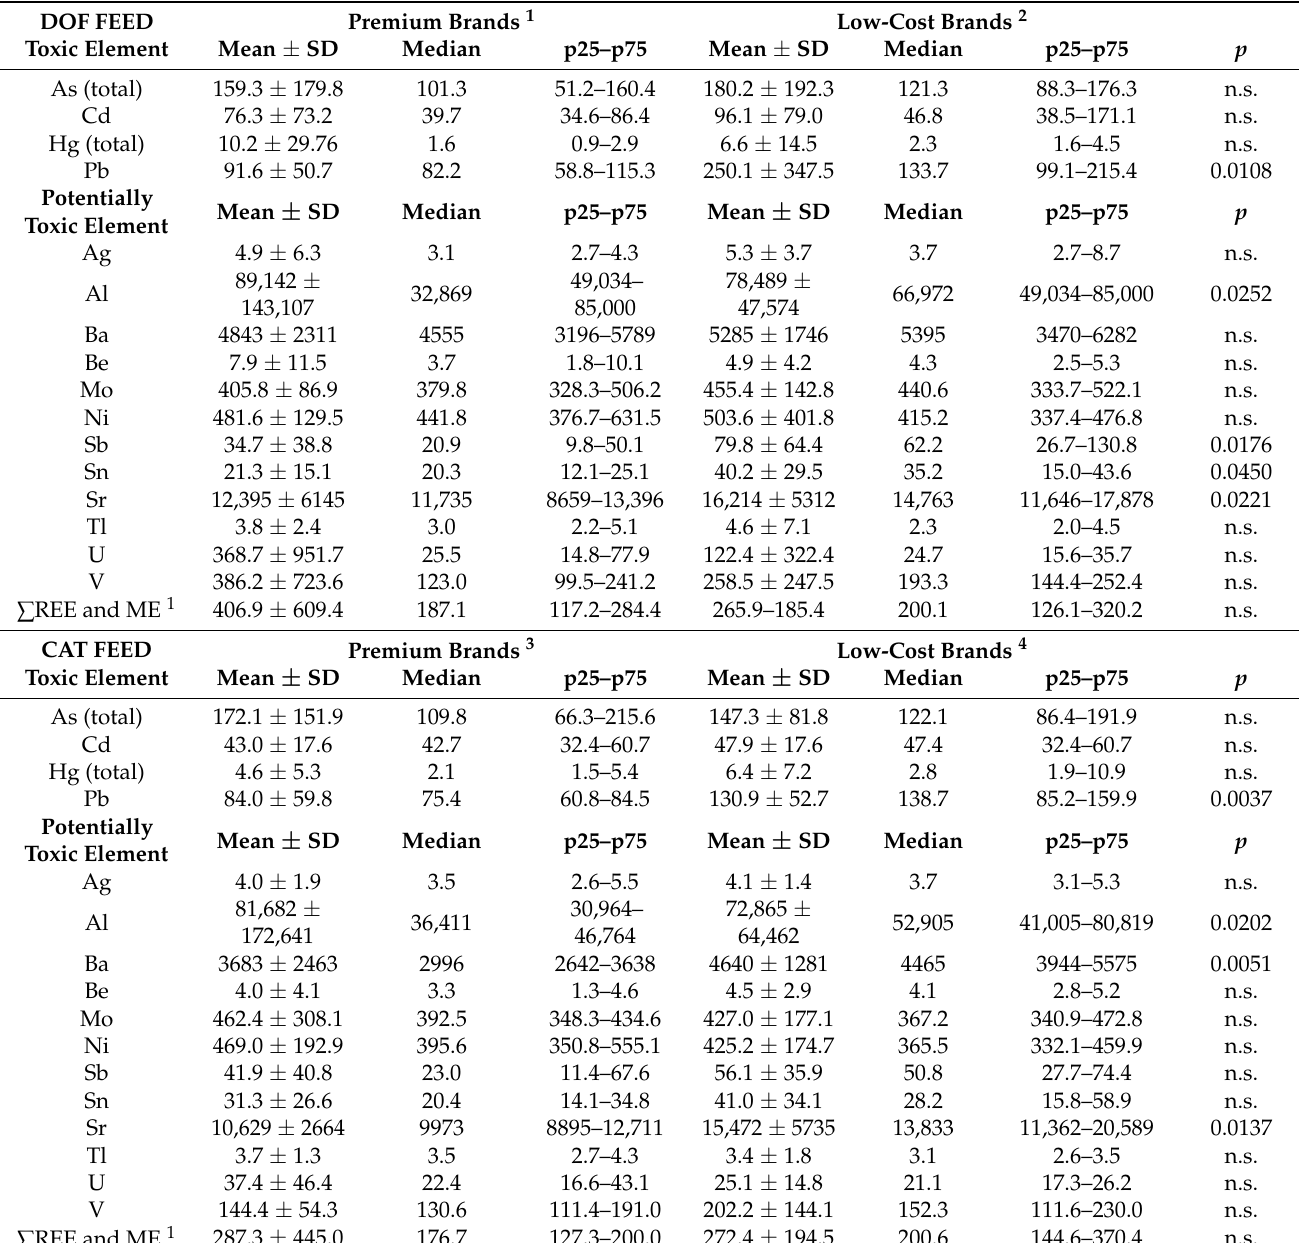
Table 2. Content of toxic and potentially toxic elements in pelleted dry food for dogs and cats, separated by commercial quality (based on price). Results are expressed in ng element /g feed